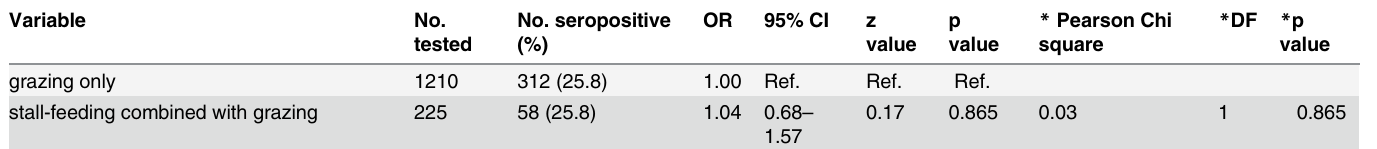
The final multivariable mixed-effects logistic regression model to examine the effect of poten- tial risk factors on RVFV seropositivity in domestic ruminants included soil water holding capacity properties in the sampled area, age of livestock and animal source into the herd (Table 4). Animals sampled from the villages within the districts with soils of good water hold- ing capacity had higher odds of RVFV seropositivity than animals sampled in the areas with soils of poor water holding capacity (OR = 1.97; 95% CI: 1.58, 3.02; p < 0.001). The odds of seropositivity increased with increasing age, in that compared with animals aged 1 – 2 years old, those aged 3 and 4 – 5 years old had 3.40 (CI: 2.49, 4.64; p < 0.001) and 3.31 (CI: 2.27, 4.82, p < 0.001) times the odds of seropositivity, respectively. The domestic ruminants which had been introduced into the herd had significantly higher odds of seropositivity than animals born within the herd (OR = 5.08, CI: 2.74, 9.44; p < 0.001). There was no evidence of collinearity or effect modification between these risk factors and no confounding effect was detected. The intra-cluster correlation coefficient expressing the within-herd clustering of variation was 0.06. The assessment of the predictive accuracy of the final multivariable model based on the area